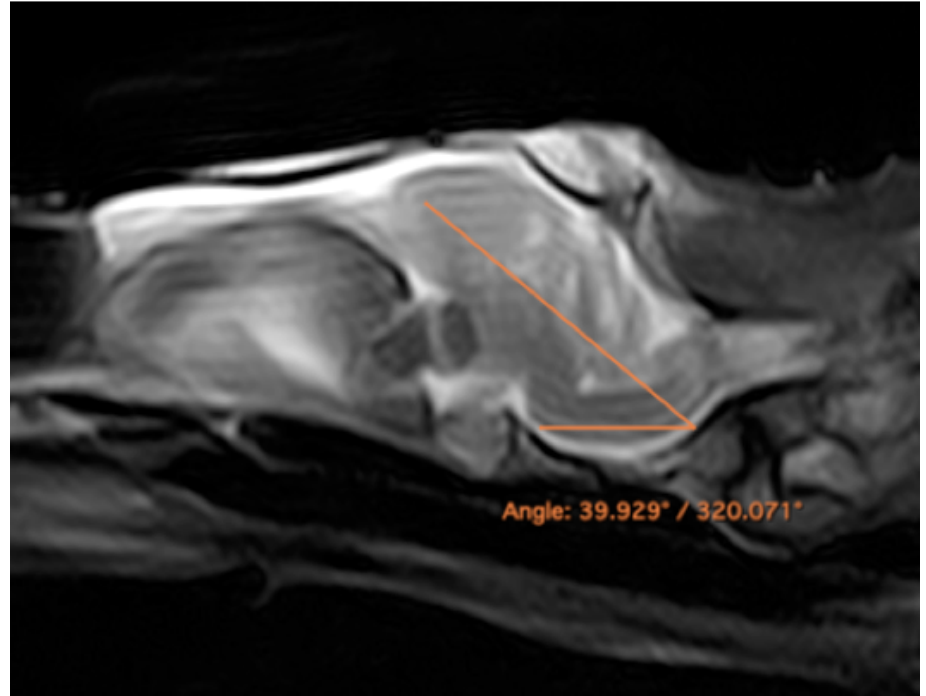
Figure 9. Rhinoceros iguana encephalic angulation, sagittal T2W image with respect to the horizon ‐ tal axis of the myelencephalon (40°).